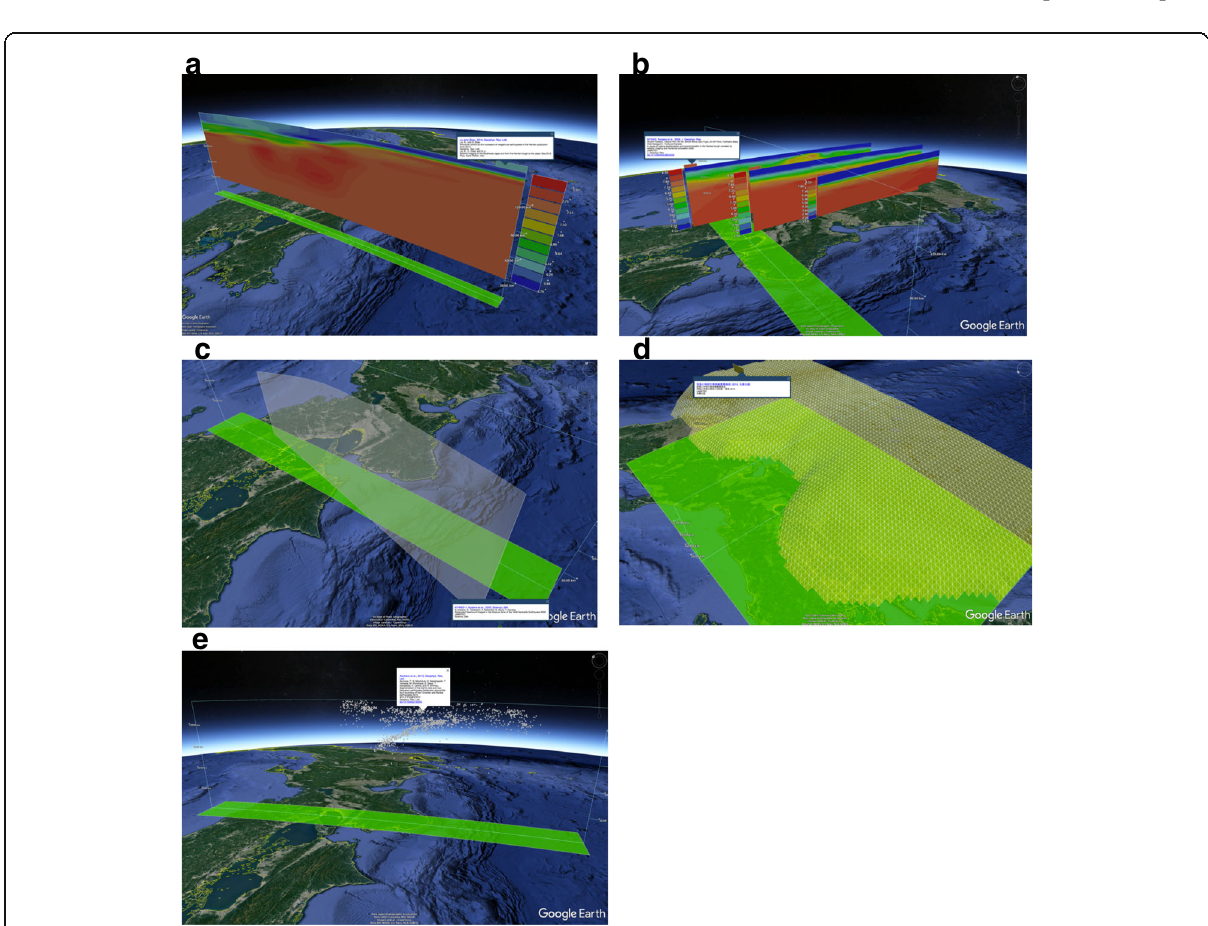
Fig. 3 Examples of seismic structural model visualizations using Google Earth. The green rectangles on the Earth ’ s surface show the user-defined search area, and the source references of the models are shown in the white balloons. a 3D seismic velocity model (Liu and Zhao 2014; Liu et al. 2013). b 2D seismic velocity model (Kodaira et al. 2006). c 2D plate geometry model (Kodaira et al. 2000). d 3D plate geometry model (Nakanishi et al. 2018). e Hypocenter distributions (Akuhara et al.